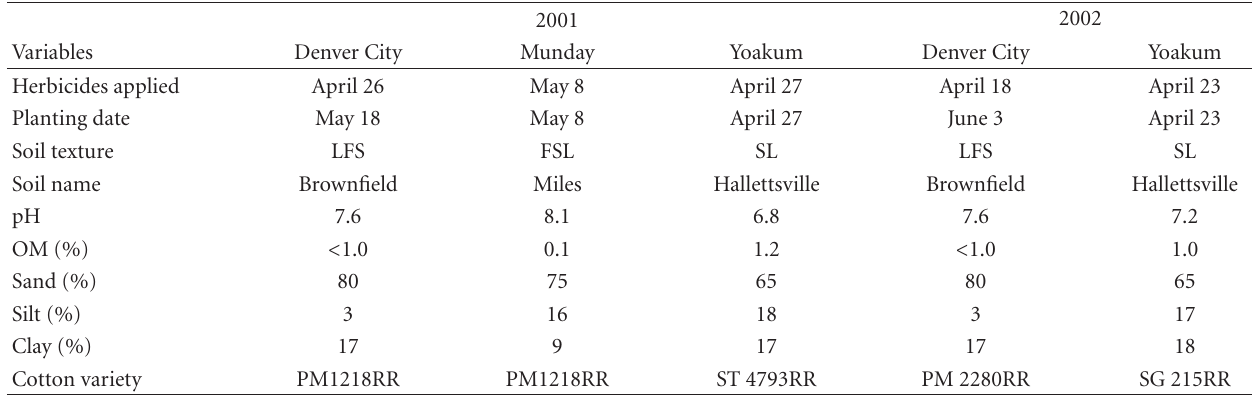
Table 1: Cotton varieties, planting dates, and soil characteristics of each